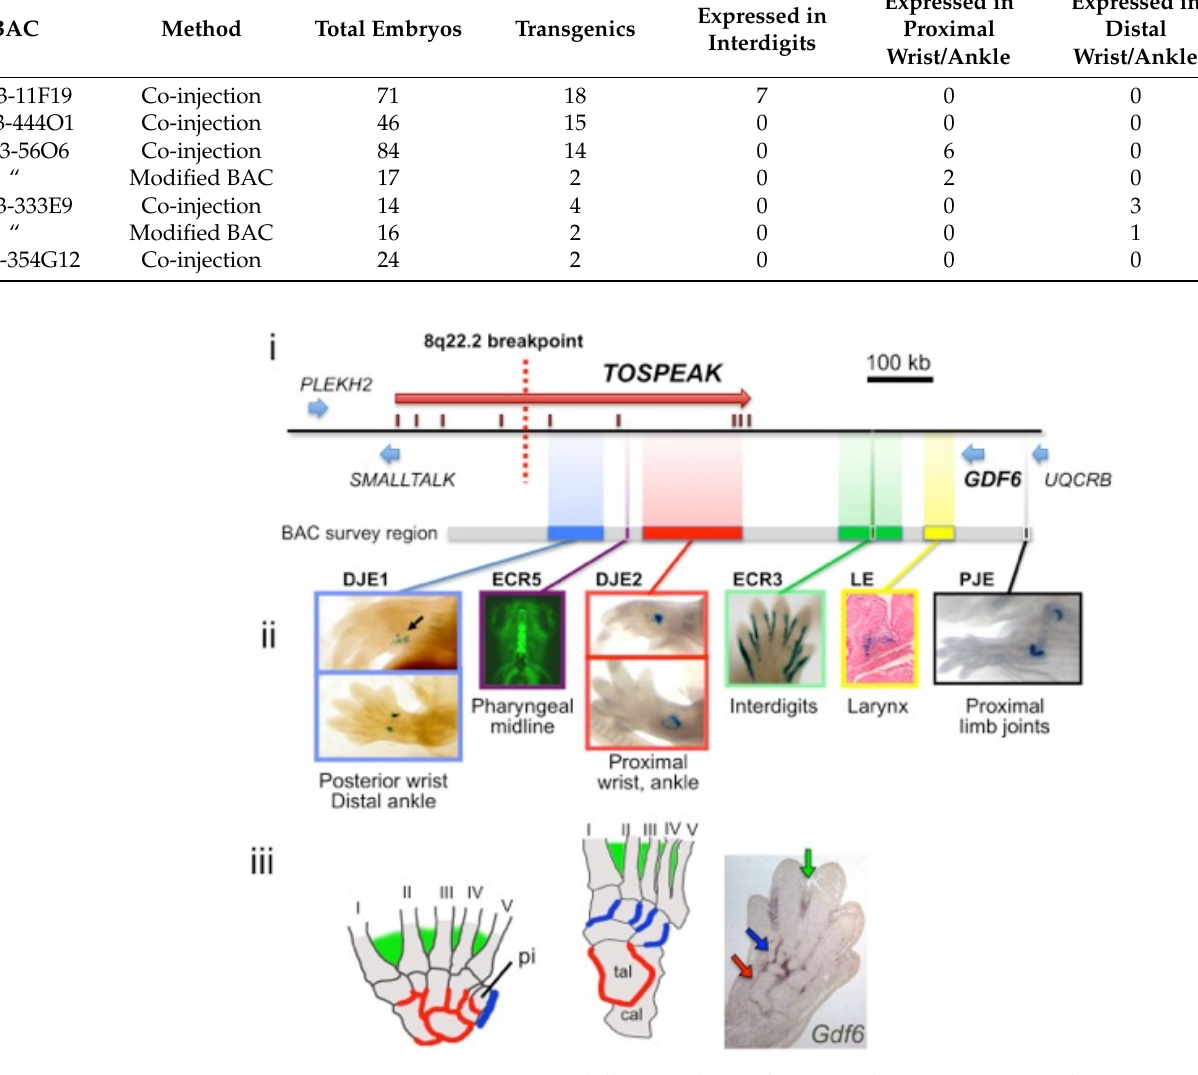
Figure 8. Transgenic mouse modelling analysis of GDF6 enhancer tissue specificity . GDF6 en- hancer specificity mapping in transgenic mice using mouse BAC clones (Table 2) and conserved elements from transgenic reporter assays in mice or zebrafish. ( i ) The grey bar indicates the region of homology to a set of mouse BACs tested for enhancer activity (see Section 2). Coloured bars in- dicate positions of human alignment to murine regions that contain developmental enhancers based on BAC data (images). ( ii ) Enhancers revealed by transgenic reporters. The pharyngeal midline en- hancer (ECR5) and proximal limb joint enhancer (PJE) are strongly conserved [17,23]. Note an en- hancer region (blue bar) that drives expression in a small domain at the posterior side of the mouse forelimb paw along the pisiform ( ii , left, top), and in distal hind limb joints (ii, left, bottom). ( iii ) Diagrams of human hand and foot skeletons, compared to Gdf6 mRNA expression in E14.5 mouse hind limb section . Red, green and blue colour-coding in ( ii ) and ( iii ) reflect the skeletal domains where enhancers in ( ii ) are expressed embryonically, and also the corresponding specific domains of Gdf6 mRNA that overlap with enhancer patterns in ( ii ). pi: pisiform. cal: calcaneus; tal: talus.